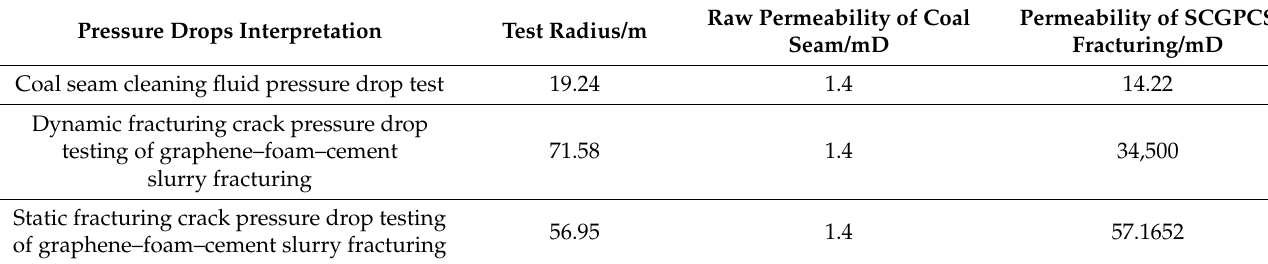
Table 1. Pressure drops interpretation